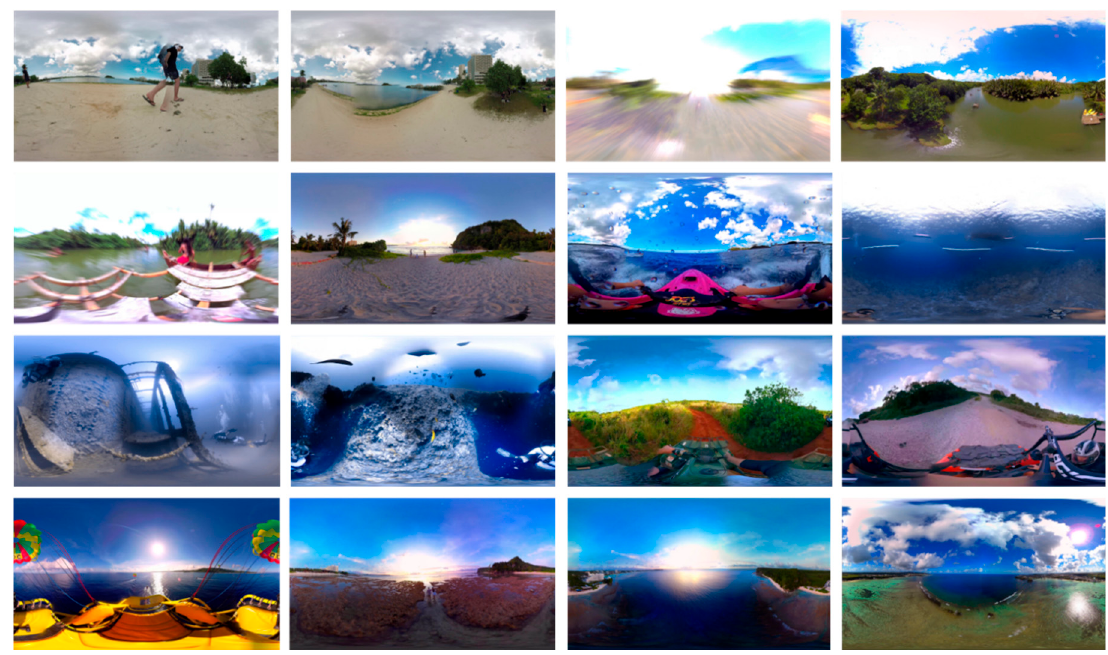
Figure 3. Representative distorted panoramic images from test set B.